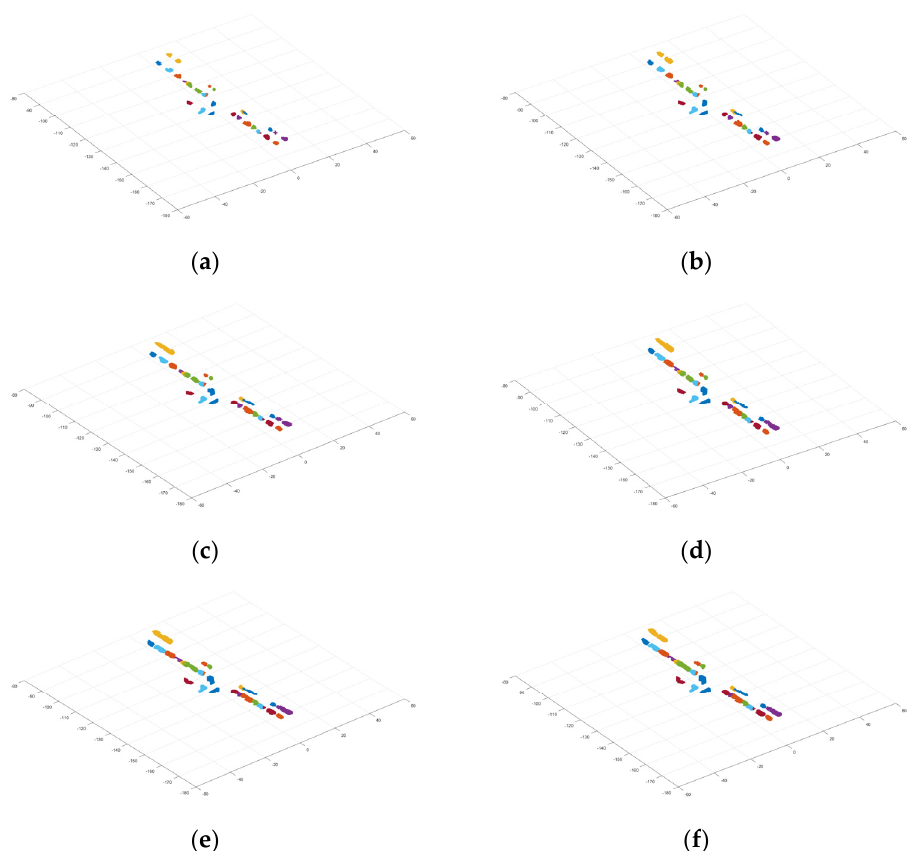
Figure 16. Neighborhood changes of region growth based on relative tension during the iterative process. Different neighborhoods are displayed in different colors. ( a – f ): different neighborhood segmentation results during the incremental iterative process.